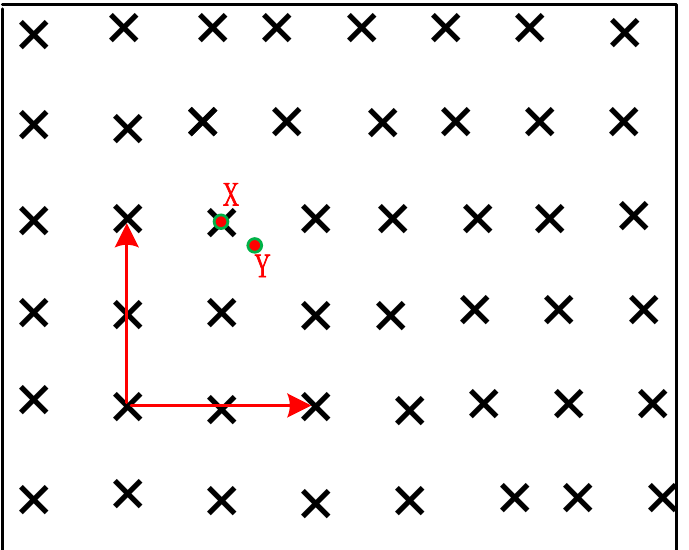
Figure 2. Diagram of nearest grid search.